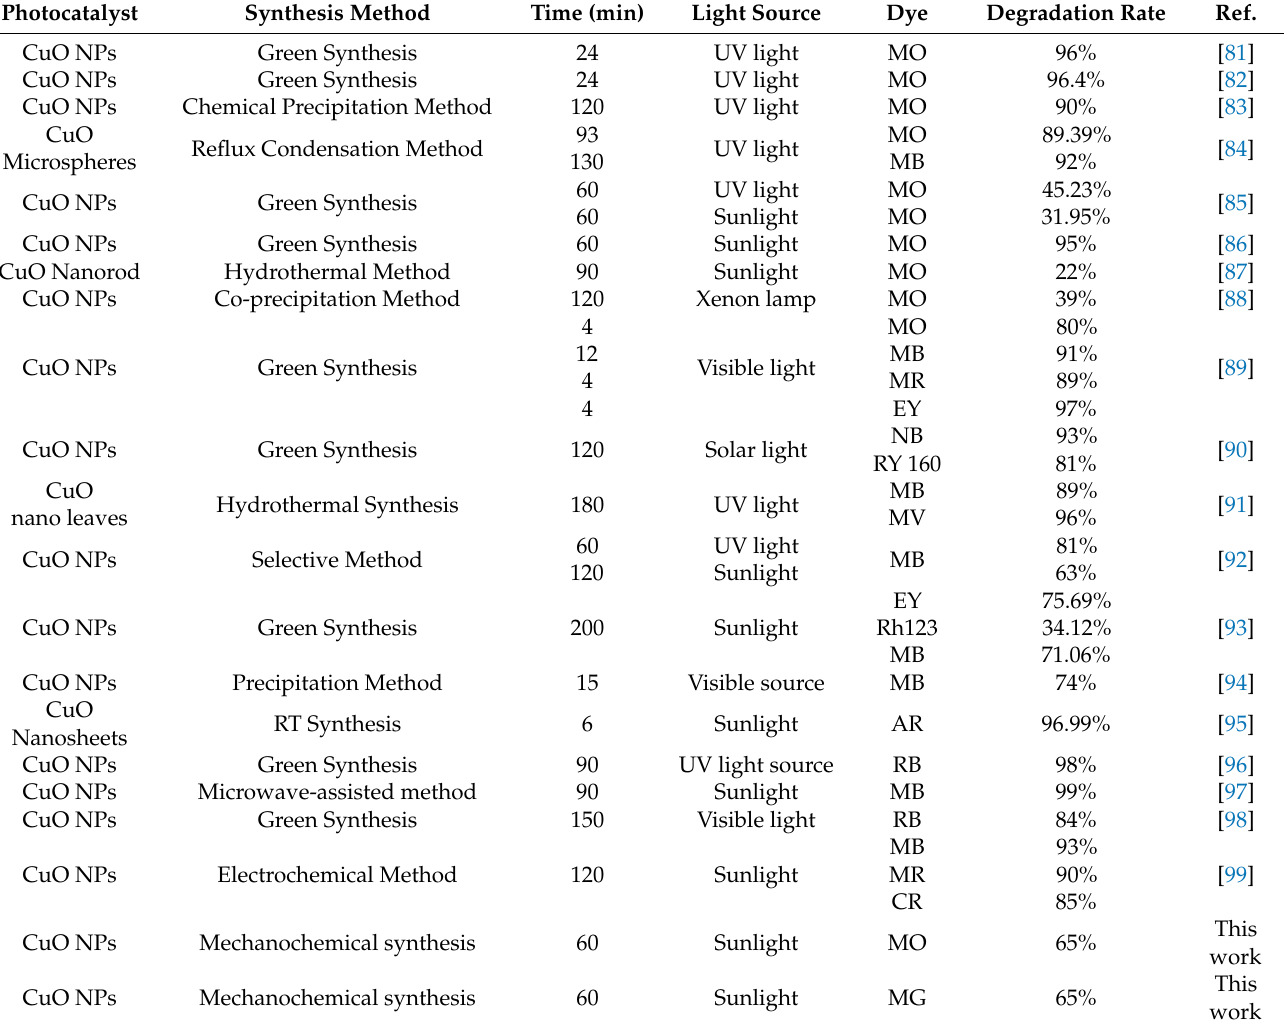
Table 2. Comparative study of photocatalytic degradation of dyes using CuO based